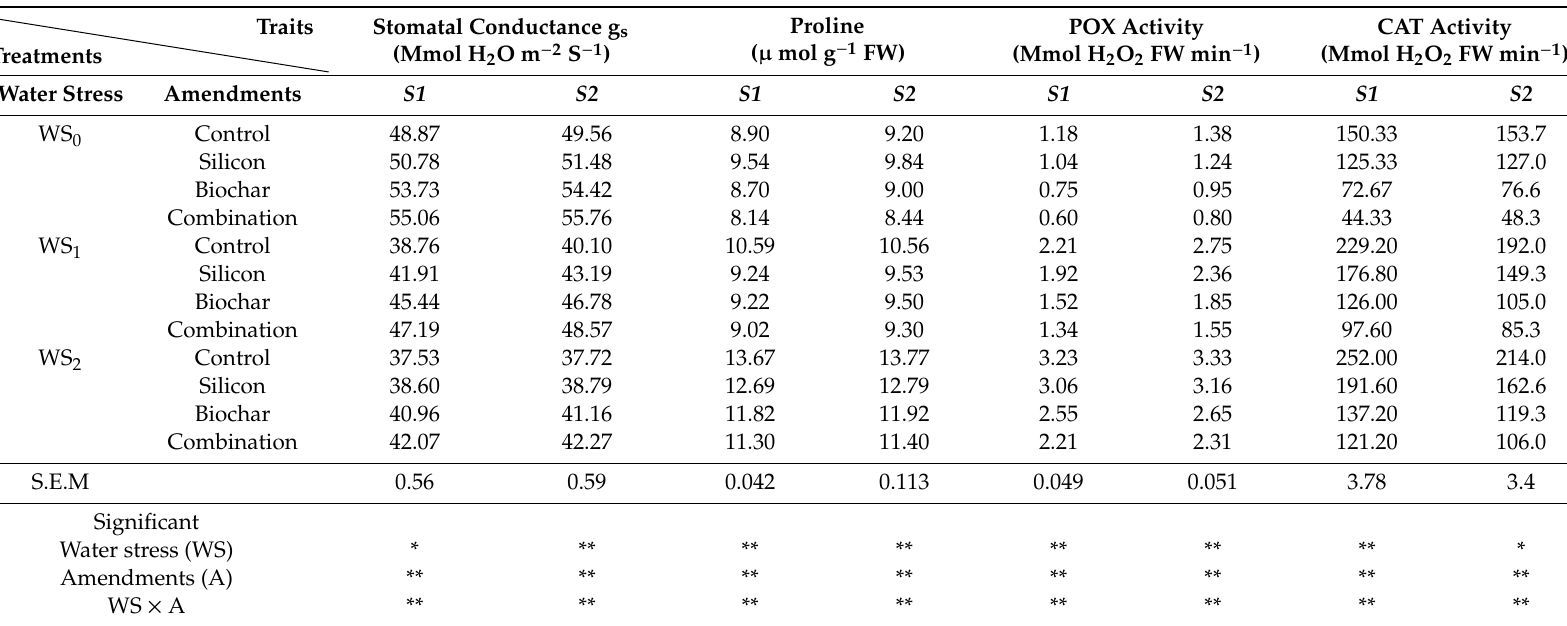
Table 2. Interaction e ff ects of amendments and water deficit stress treatments on physiological traits of sunflower during growing seasons 2016 and 2017.